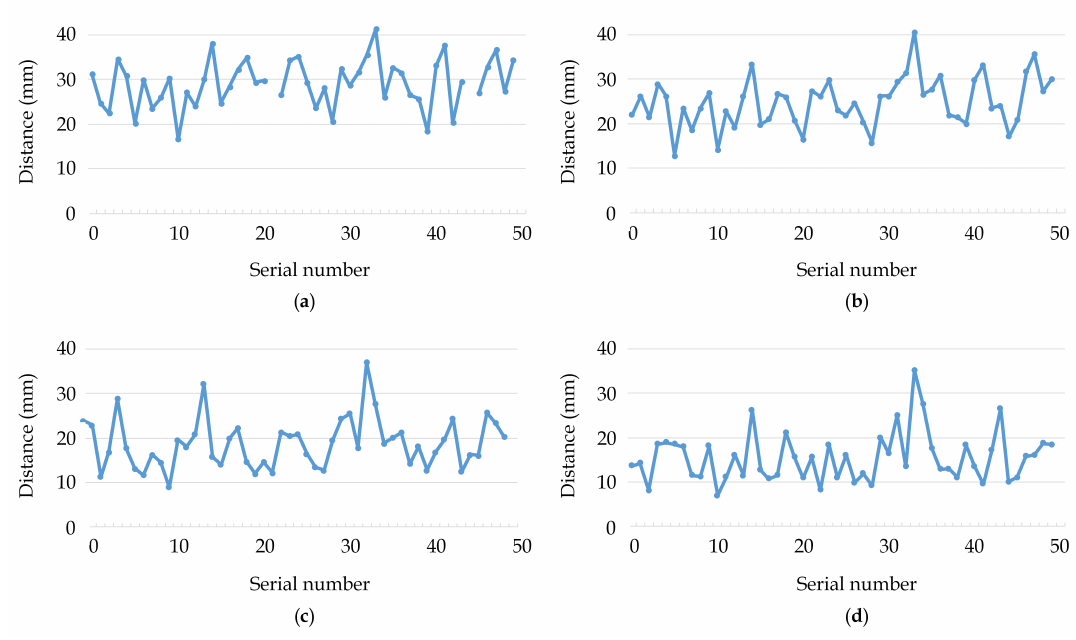
Figure 9. Fertilizer offset distances at different soil depths: ( a ) 120 mm; ( b ) 140 mm; ( c ) 160 mm; ( d ) and 180